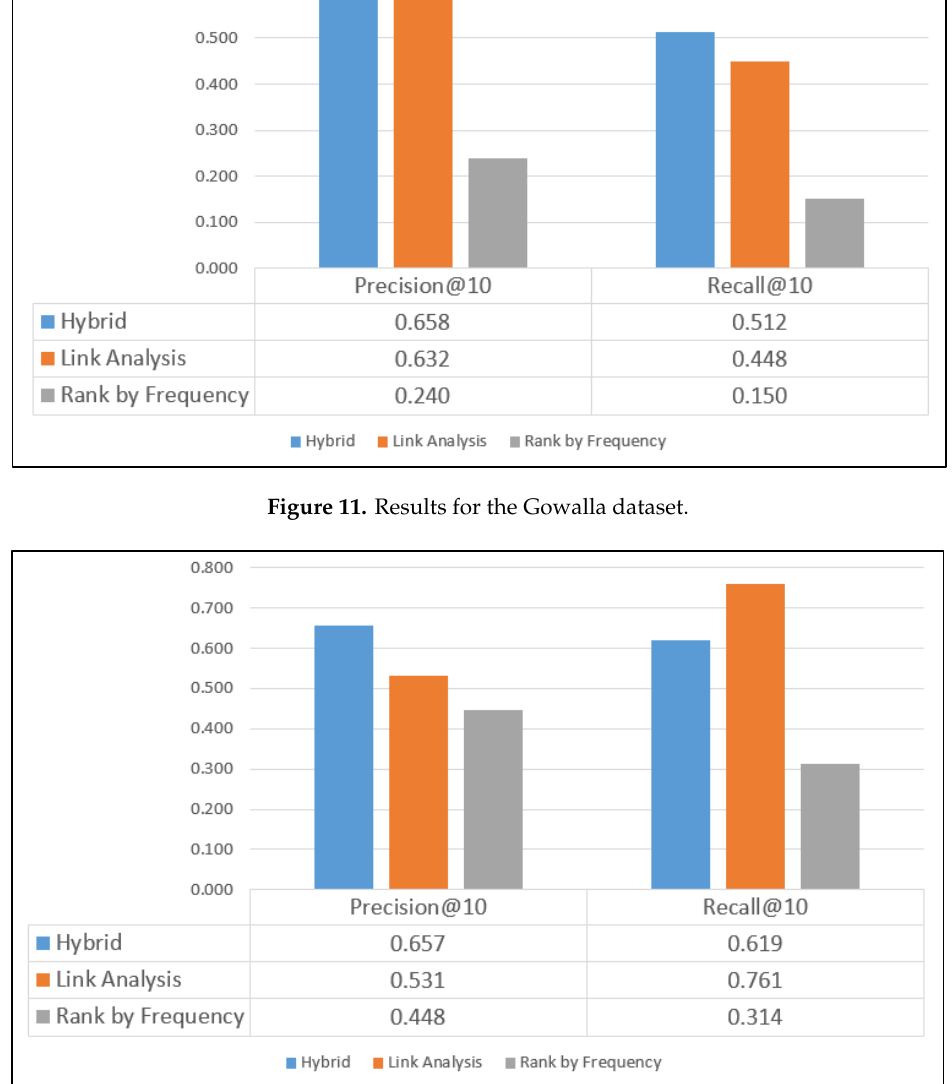
Figure 12. Results for the Brightkite dataset.